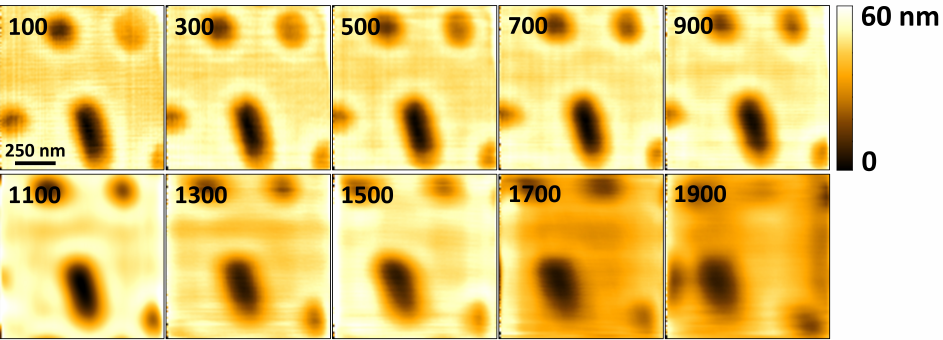
Figure 8. Topographical images of a 1 µ m × 1 µ m Blu-ray disk scan consisting of 100 × 100 pixels acquired at different line rates. The line rate, in Hz, is indicated in the top left corner of each image. The images are acquired using sinusoidal raster scan waveforms to reduce the effects of XY-scanner